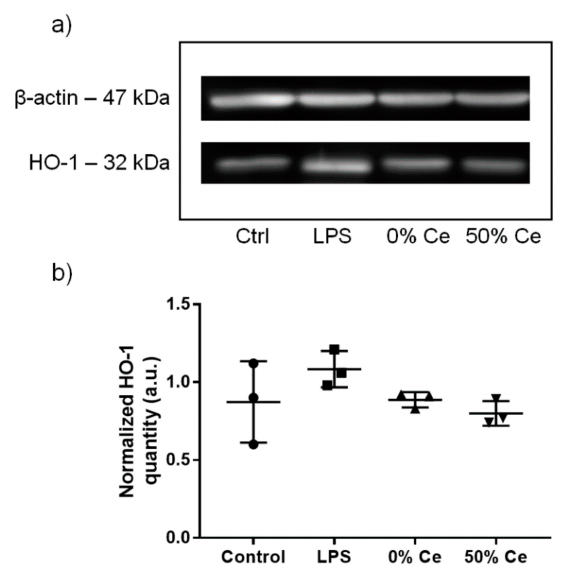
Figure 7. HO-1 expression of RAW 264.7 cells after 24 h of exposure to 10 µ g/mL of Gd 2 O 2 S (0% Ce) nanoparticles and GdCeO 2 S (50% Ce) nanoparticles. Cell treatment with 10 µ g/mL of LPS was used as positive control. ( a ) Results from western blot analysis of HO-1 and β -actin. ( b ) Average quantities of HO-1 deduced from the intensity of the fluorescent bands of three repeated western blot analyses. They are normalized with the corresponding β -actin